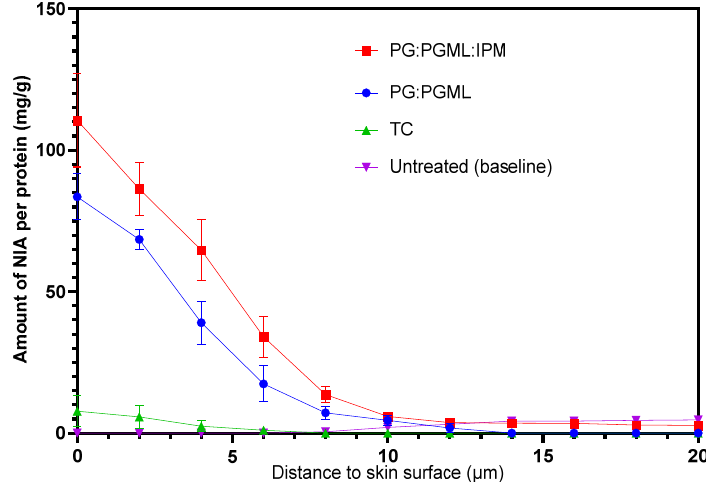
Figure 3. Depth profiles of NIA (mg/g) across the human volar forearm skin as a function of distance to the skin surface following a 60 min application of formulations in vivo ( n = 8; mean ± SEM). The untreated skin served as a baseline and has been subtracted from the other profiles.